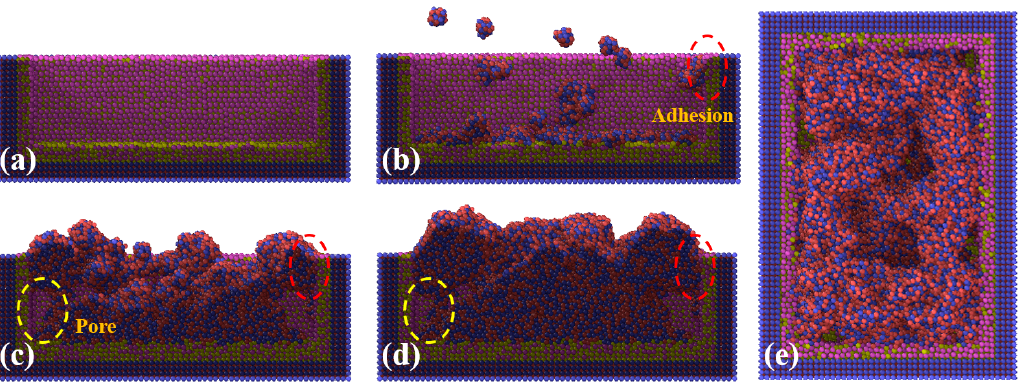
Figure 5. The deposition process of granulated NiTi powders ( a – d ) cross-section views corresponding to the state of 0 ps, 50 ps, 300 ps, and 500 ps, respectively. Red circles present adhesion phenomenon. Yellow circles are the pores formed during the deposition process. ( e ) Top view obtained after relaxation.